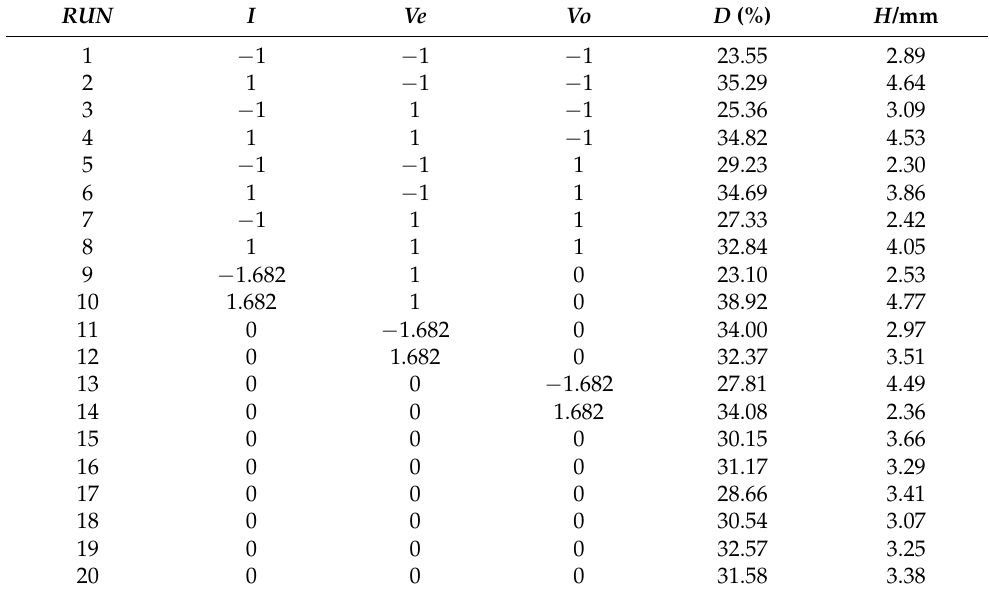
Figure 1. Cross sectional view of a weld. Table 3. DOE Table with Responses.